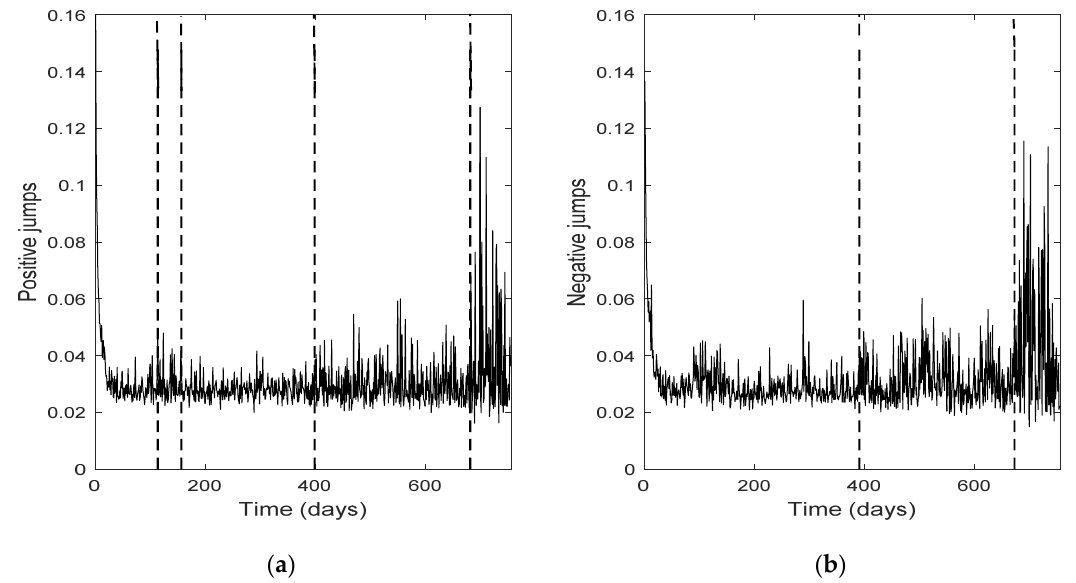
Figure 5. ( a ) Change points in the estimated positive jumps of NASDAQ index; ( b ) Change points in the estimated negative jumps of NASDAQ index.